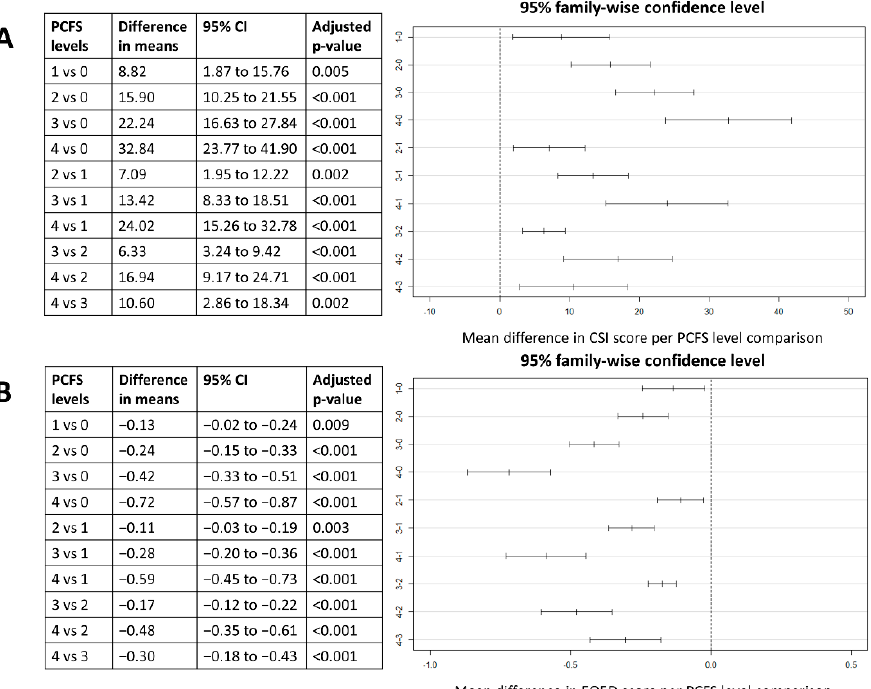
Figure 3. Post hoc comparisons between CSI scores ( A ) and EQ5D scores ( B ) for the different PCFS Scale group levels with a visual presentation of the 95% family-wise confidence intervals for all group level comparisons. Abbreviations. CI: confidence interval, CSI: Central Sensitisation Inventory, PCFS: Post-COVID-19 Functional Status Scale, vs: